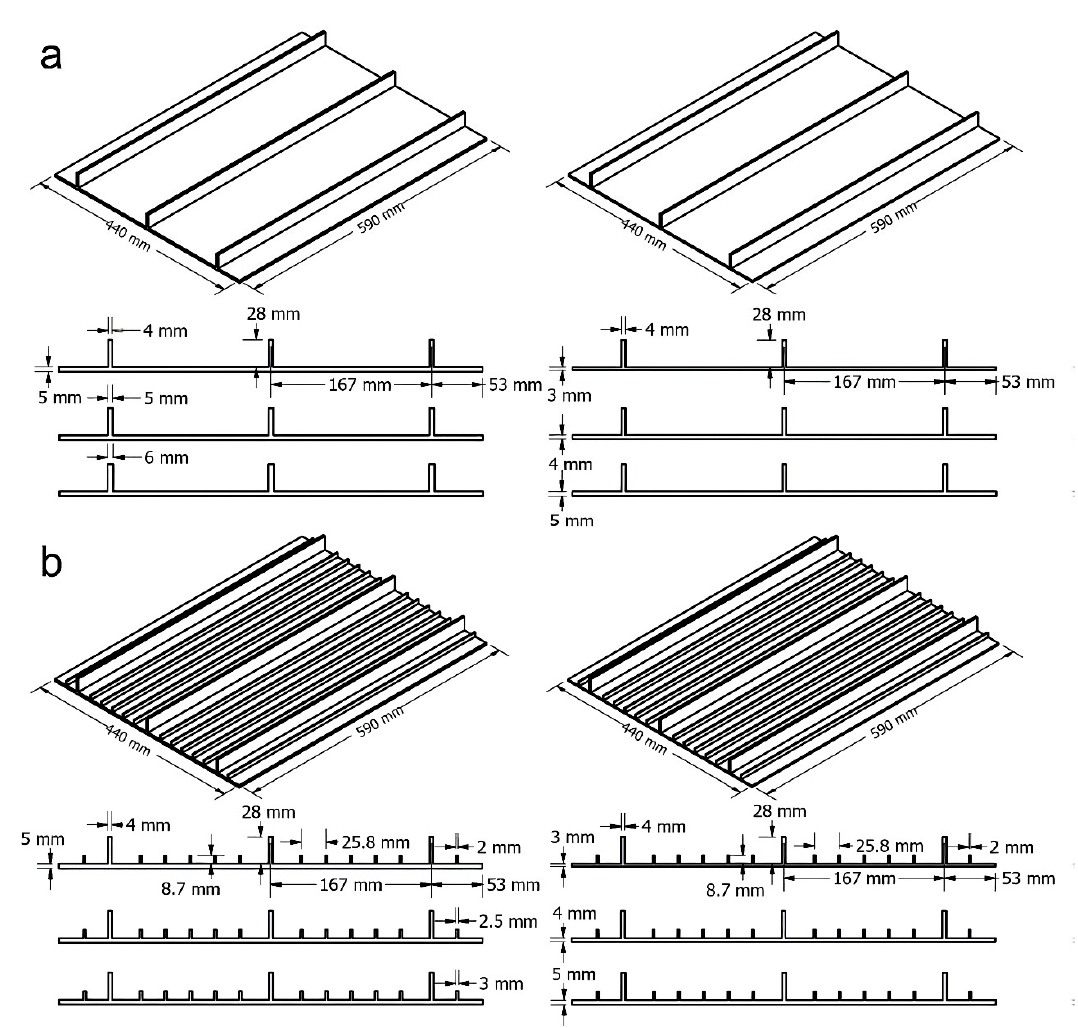
Figure 11. Geometrical design of specimens. ( a ) Specimen A and ( b ) Specimen B.